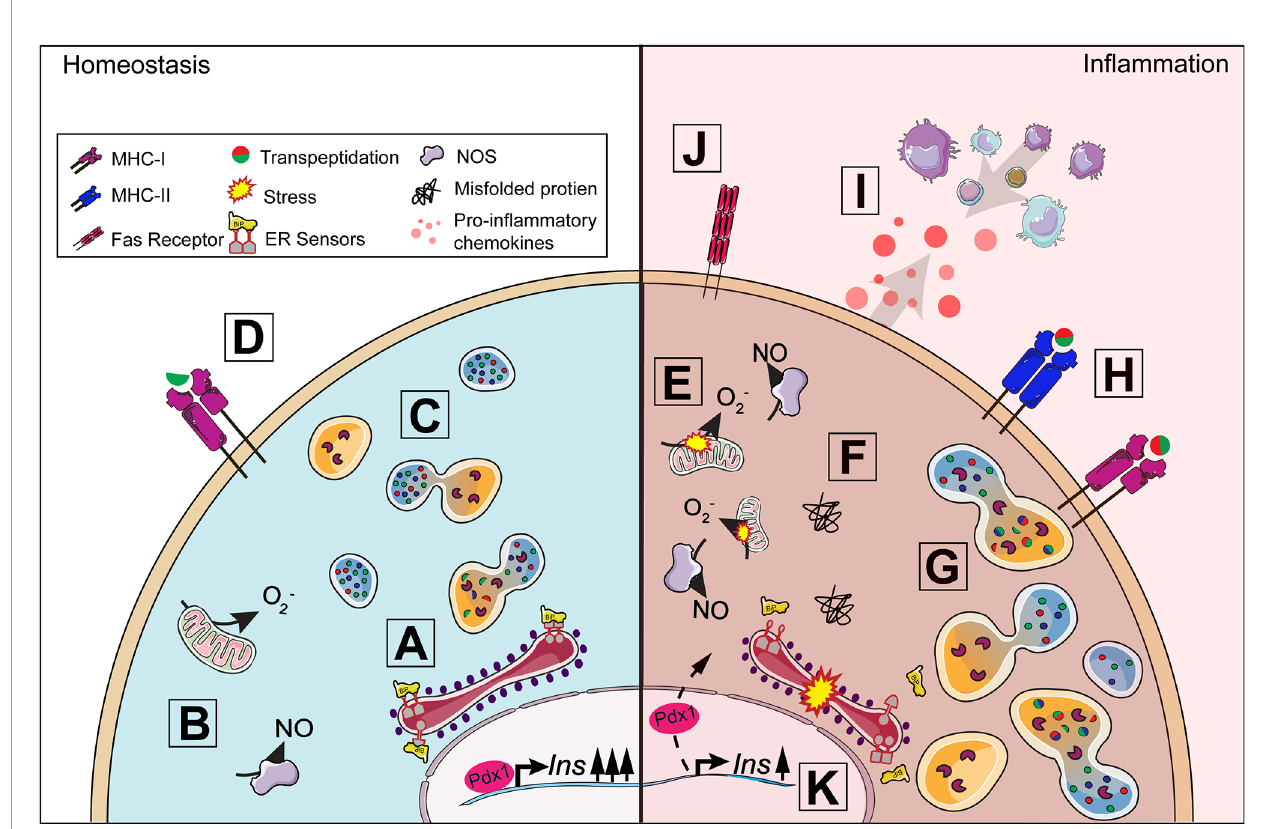
FIGURE 2 | Beta-cell response to in fl ammation. Under homeostasis conditions, insulin production is tightly coupled with cellular metabolism including protein synthesis in the endoplasmic reticulum (ER) (A) and mitochondrial function (B) . When insulin secretory granule proteins are in excess, they can be broken down and recycled by crinophagy, a process by which granules fuse with lysosomes (C) . Some peptides from this degradation process are presented on MHC-I (D) and, in healthy cells, should not lead to activation. A proin fl ammatory environment around the islet exacerbates ER and oxidative stress (E) contributing to the dysregulation of multiple processes in the beta-cell. The accumulation of misfolded proteins can result in the activation of the unfolded protein response (F) and increase lysosomal degradation of insulin secretory granule proteins (G) . Protein degradation under stress can lead to the production of neo-antigens, such as hybrid insulin peptides, through transpeptidation. ER and oxidative stress results in the upregulation of MHC-I and the unique expression of MHC-II (H) by the beta-cell allowing for increased presentation of potential neo-antigens to T cells. Fas receptor expression (J) makes the beta-cell vulnerable to Fas-mediated apoptosis. The release of chemokines (I) from the beta-cell further contributes to immune cell recruitment and the development of insulitis. Insulin production can be affected as disturbances in cellular homeostasis can lead to the translocation of Pdx1 from the nucleus to the cytoplasm, decreasing insulin production (K)